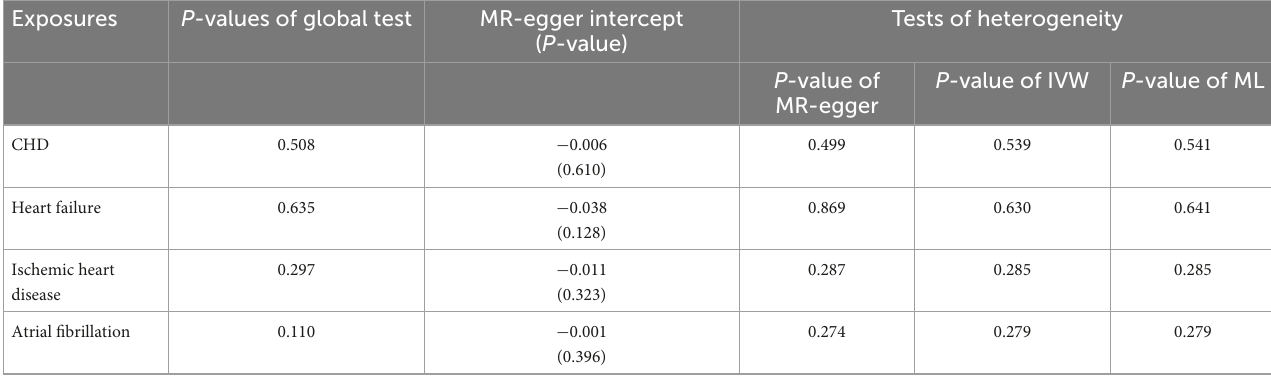
TABLE 2 Results of heterogeneity and pleiotropy tests.